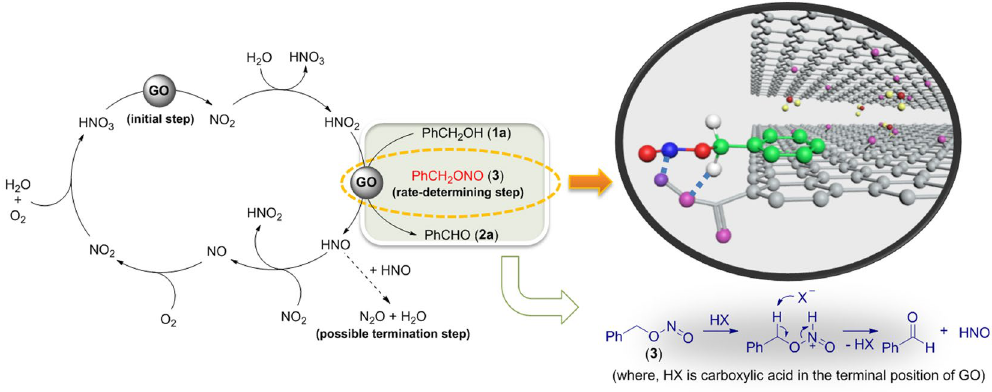
Figure 3. Proposed mechanism for the oxidation of primary alcohol to aldehyde.